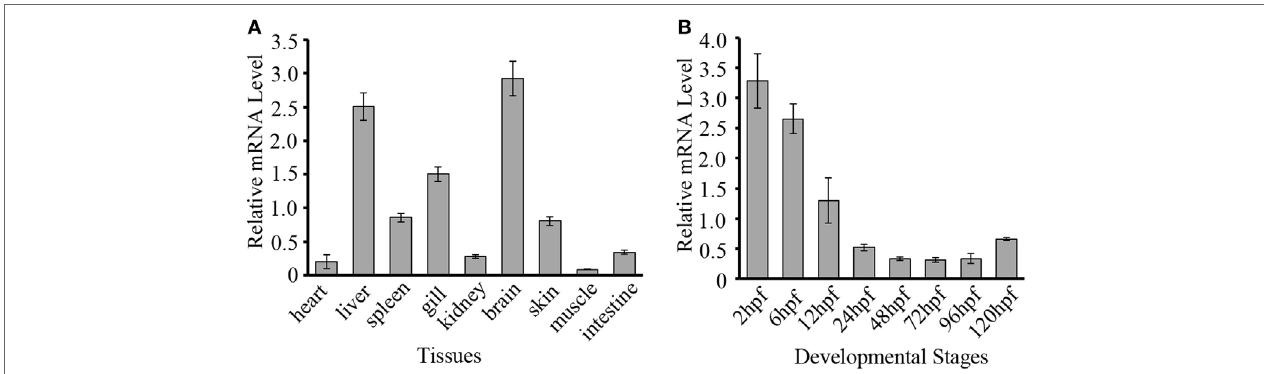
FigUre 3 | Expression patterns of Danio rerio DDX41 ( Dr DDX41) gene in different tissues and embryos at different developmental stages. (a) Expression profiles of Dr DDX41 mRNA in the different tissues as indicated. (B) Expression profiles of Dr DDX41 gene in embryos at the different developmental stages [2–120 hours post fertilization (hpf)]. β -actin was chosen as the internal control for normalization. Relative expression data were calculated by the method of 2 −Δ Ct . The vertical bars represent the mean ± SD ( n = 3). The data are from three independent experiments performed in